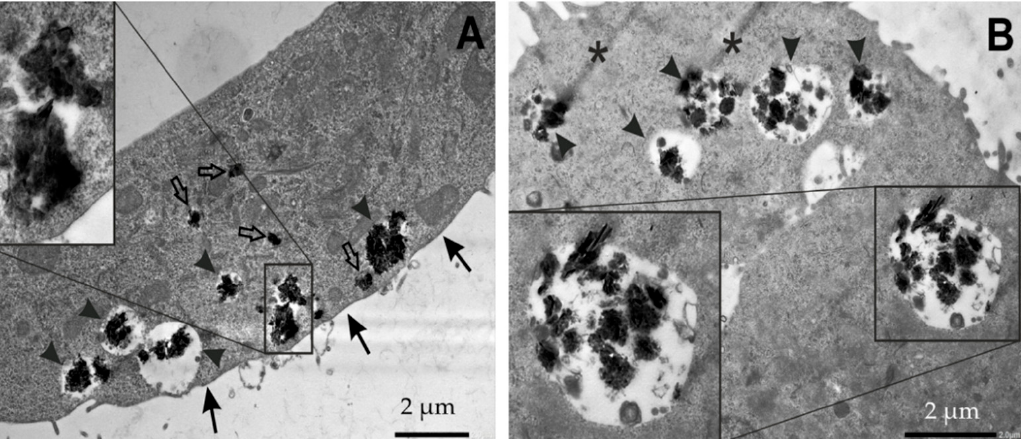
Figure 6. Representative TEM images of A549 cells confirm the internalization of graphene nanoplates. After the short-term exposition, ( A ) graphene nanoplates were located inside the cells, predominantly near the free surface of the cells (arrows). They form clusters that were fully or partly situated in the membrane-bound vesicles (arrowheads) or freely found in the cytoplasm (“empty” arrows). Following the 8-week exposition, ( B ) almost all graphene nanoplate clusters were observed inside the membrane-bound vesicles (arrowheads) in any parts of the cells. In comparison to the short-term exposition, vesicles containing graphene nanoplate clusters frequently reached bigger sizes. Smudges were arising from sectioning (asterisks). Scale bar A 2 µm (mag. 4000×), insert mag. 11,100×; B 2 µm (mag. 5000×), insert 7400×.